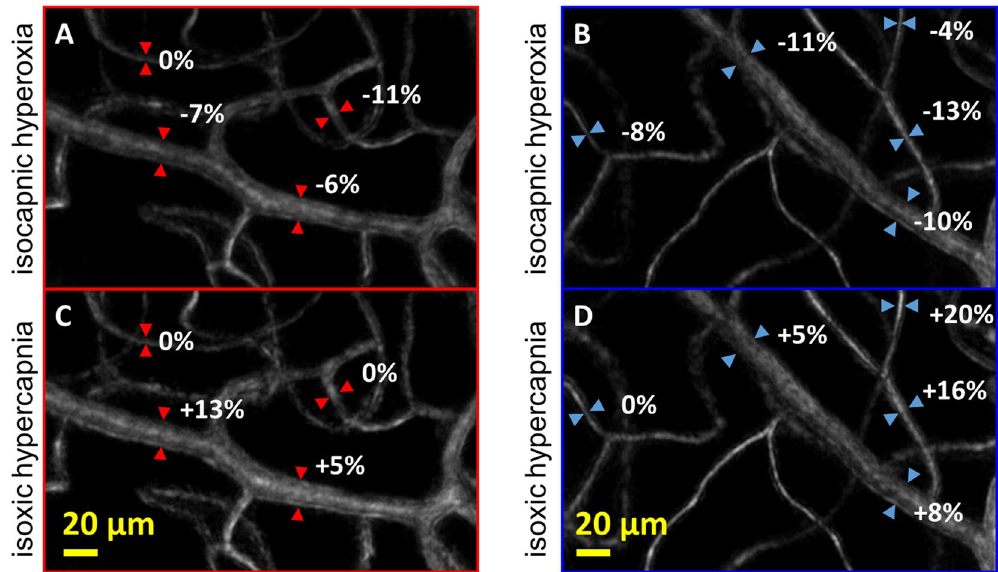
Figure 2. Examples of a region of interest containing a “major” arteriole (red) and a “major” venule (blue), with vessel responses following isocapnic hyperoxia ( A , B ) and isoxic hypercapnia ( C , D ) marked.